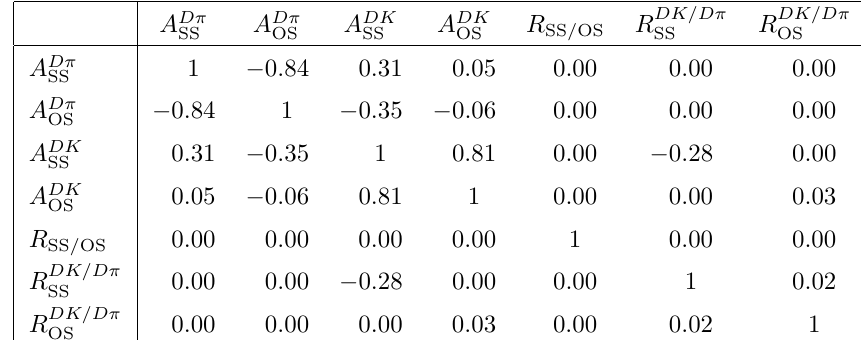
Table 7 . Systematic correlation matrix for the non Open